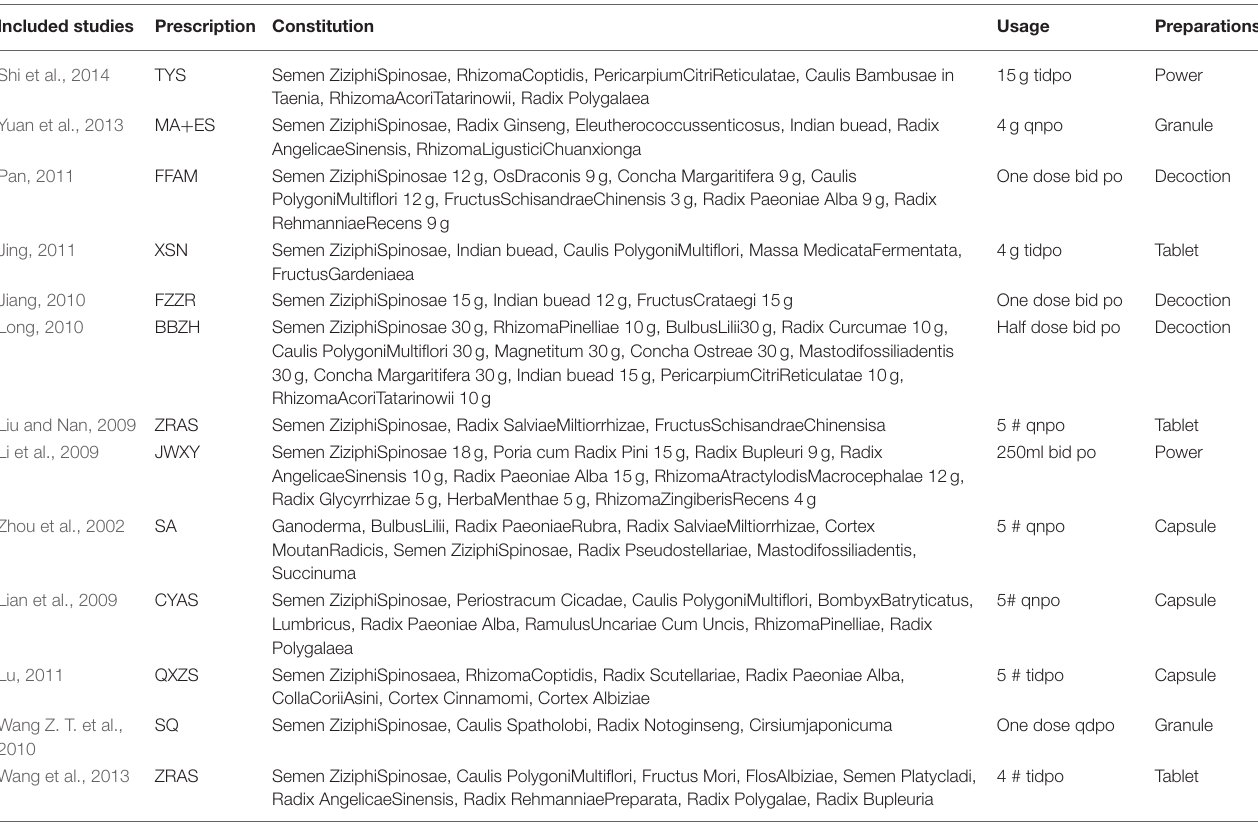
TABLE 3 | Ingredients and usage of FSZR formulae.